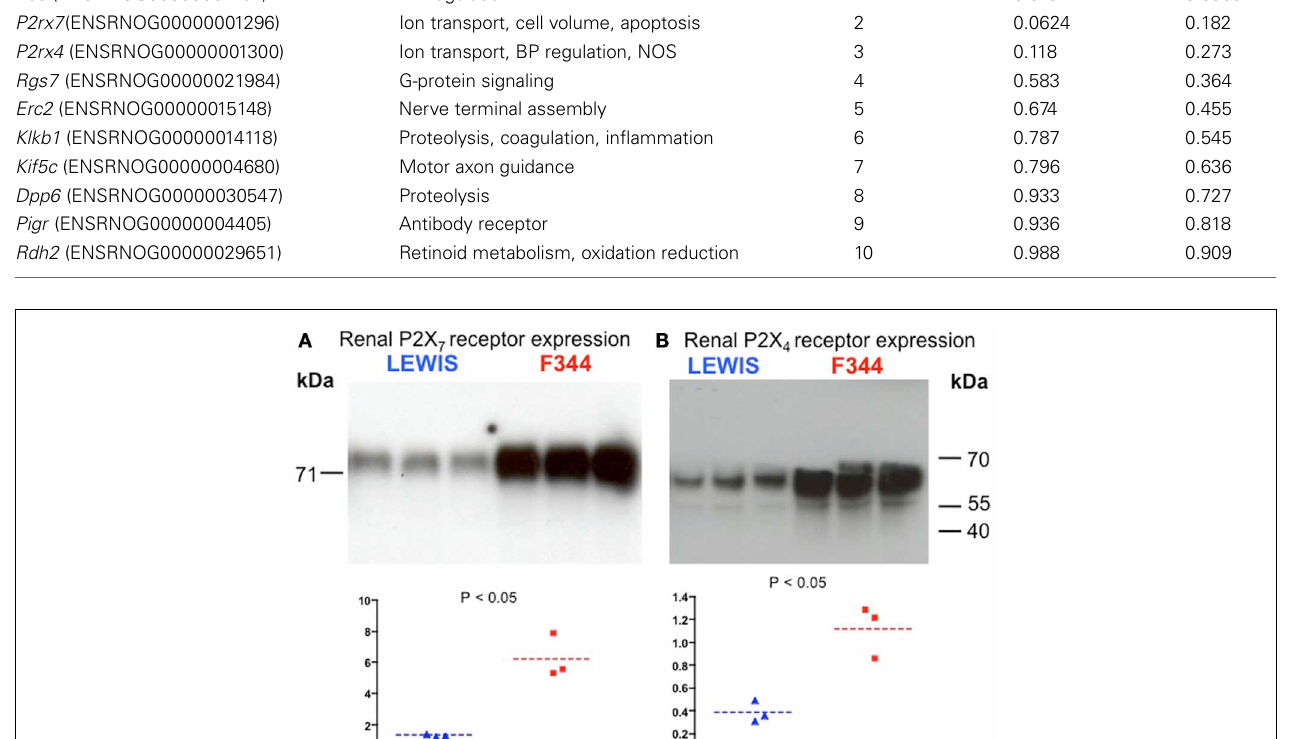
FIGURE 3 | Western blot analysis of (A) P2X 7 receptor and (B) P2X4 receptor expression in whole kidney homogenates. The top panels show the blot performed in Lewis and F344 rats ( n = 3 in each). The bottom panels show the blot intensity (normalized to protein loading) quantified by densitometry.